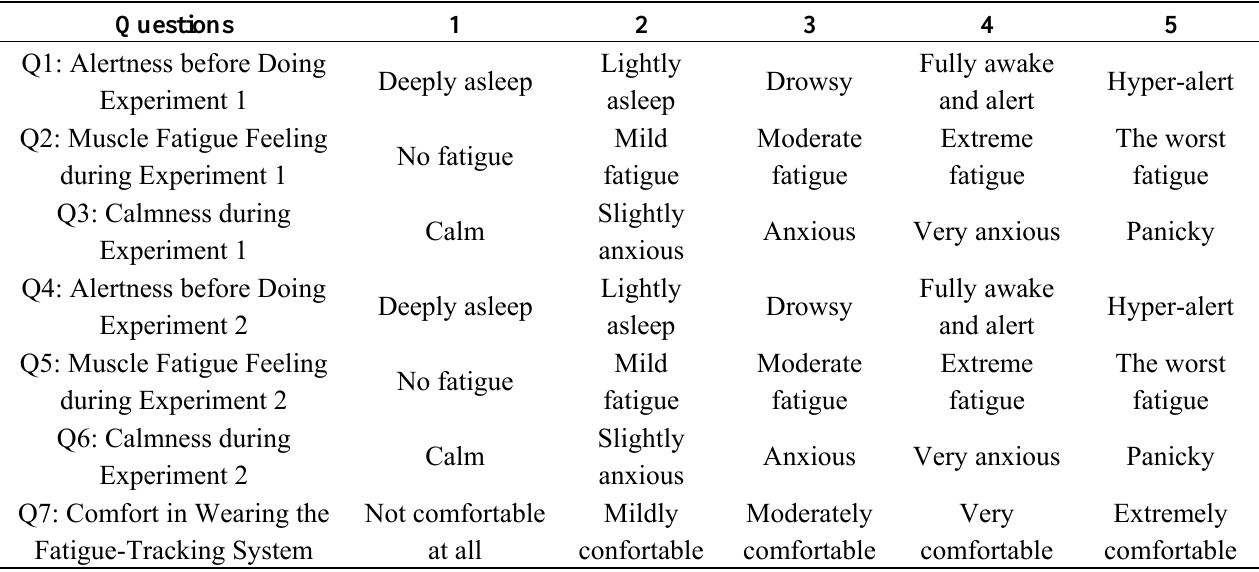
Table 3. Survey of fatigue